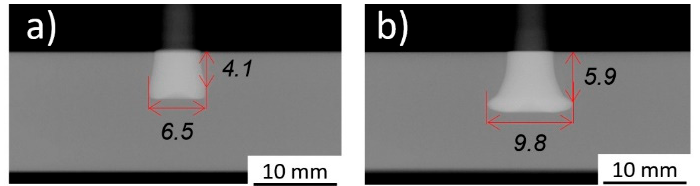
Figure 6. X-ray tomography of: ( a ) Condition 33 (RS = 19,000 rpm; FT = 1.8 s; FoT = 1.5 s; FF = 1500 N; FoF = 4500 N); ( b ) Condition 36 (RS = 19,000 rpm; FT = 1.8 s; FoT = 1.5 s; FF = 2500 N; FoF = 5700 N).